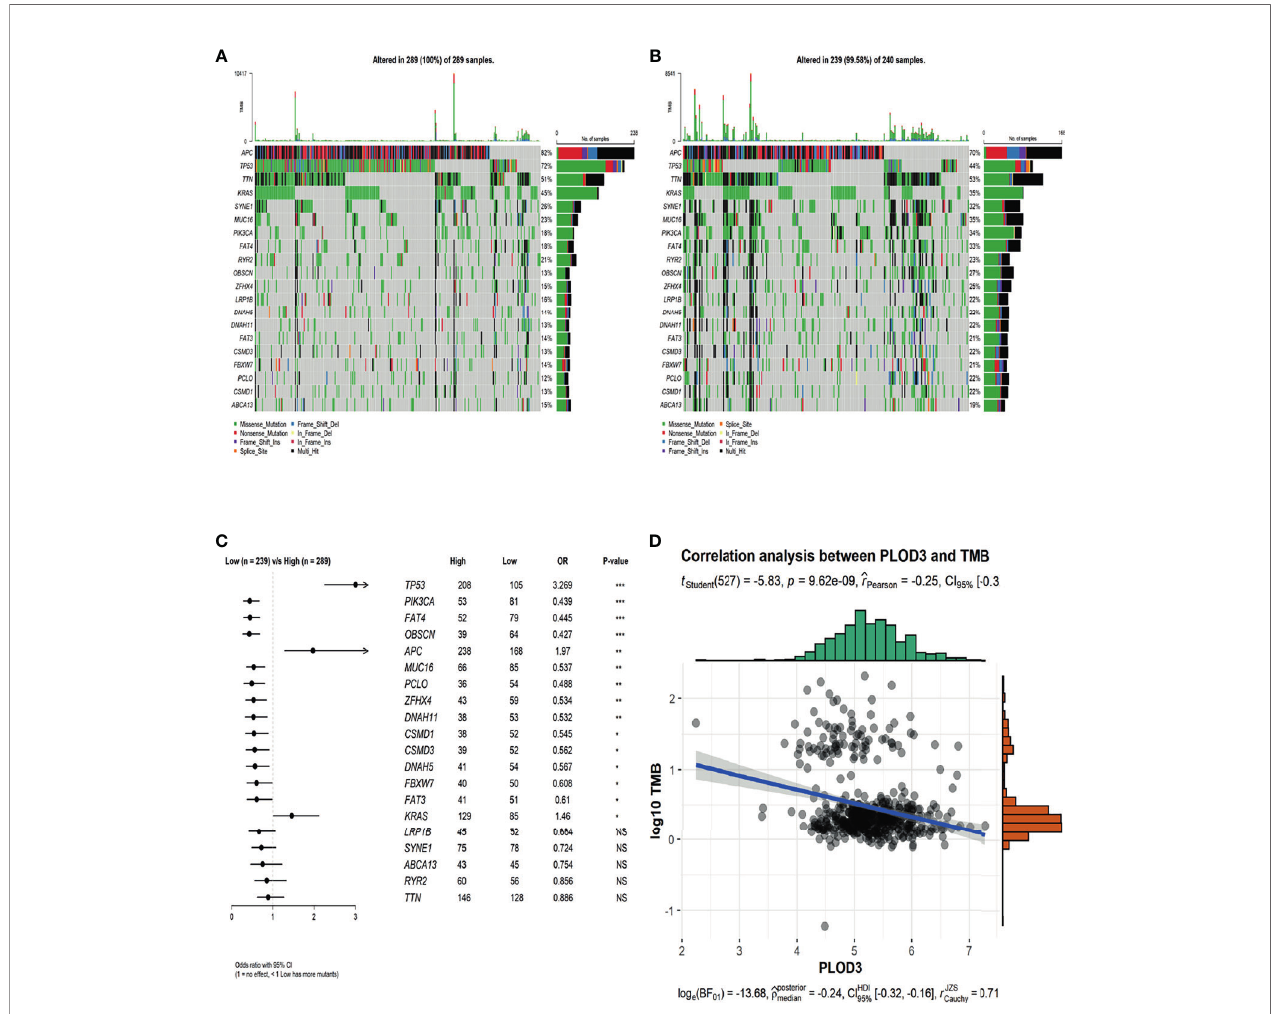
FIGURE 4 | Genomic mutation pro fi les and TMB characteristics of PLOD3 -high and PLOD3 -low groups. (A) Distribution of top 20 frequently mutated genes in PLOD3 -high TCGA-CRC subgroups. The upper bar plot shows the TMB for each patient, and the left bar plot indicates the gene mutation frequency in different risk groups. (B) Distribution of top 20 frequently mutated genes in PLOD3 -low TCGA-CRC subgroups. The upper bar plot shows the TMB for each patient, and the left bar plot indicates the gene mutation frequency in different risk groups. (C) Differentially mutated genes between PLOD3 -high and low groups. The p values were calculated by Fisher ’ s exact test. * p < 0.05; ** p < 0.01; *** p < 0.001, NS, No Signi fi cance. (D) Correlation analysis of TMB and PLOD3 in TCGA-CRC